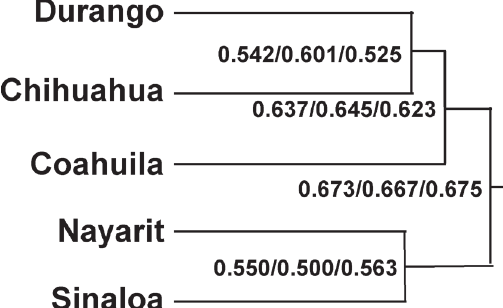
Figure 5. Results of cluster analysis of the herpetofaunas of Durango and its neighboring states (Chi- huahua, Coahuila, Nayarit, and Sinaloa). The distances provided are Euclidean distances for the entire herpetofauna, reptiles only, and amphibians only,